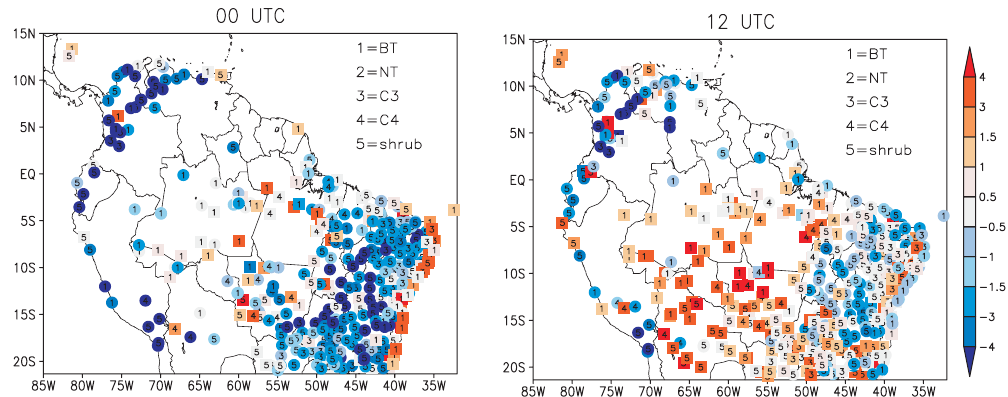
Fig. 8. The colors represent the bias NCEP analysis (average difference between NCEP analysis and observation) at 00:00UTC and 12:00UTC. The numbers inside the circles (or squares) represent the predominant vegetation type at the station point, where BT = broadleaf trees, NT = needleleaf trees, C3 = C3 grasses and C4 = C4 grasses.